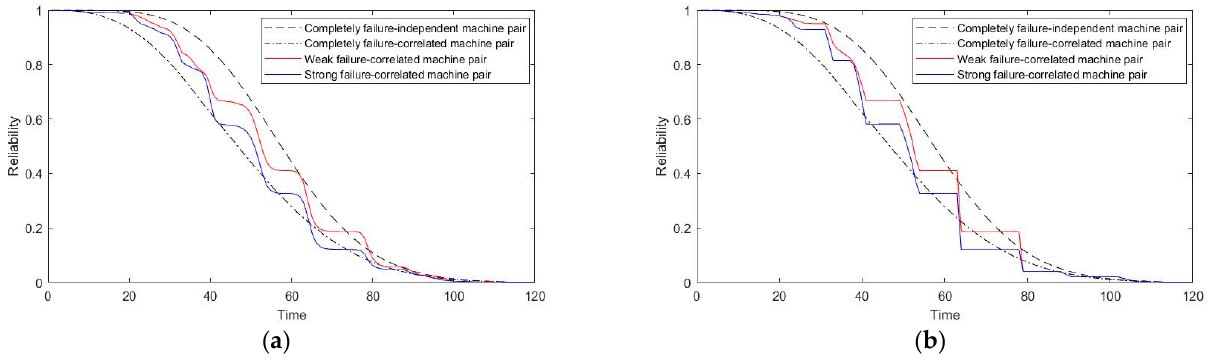
Figure 9. Subsystem reliability evaluation of Machine pair 5–6: ( a ) Gaussian membership function and double Gaussian membership function selected; ( b ) triangular membership function and trapezoid membership function selected.